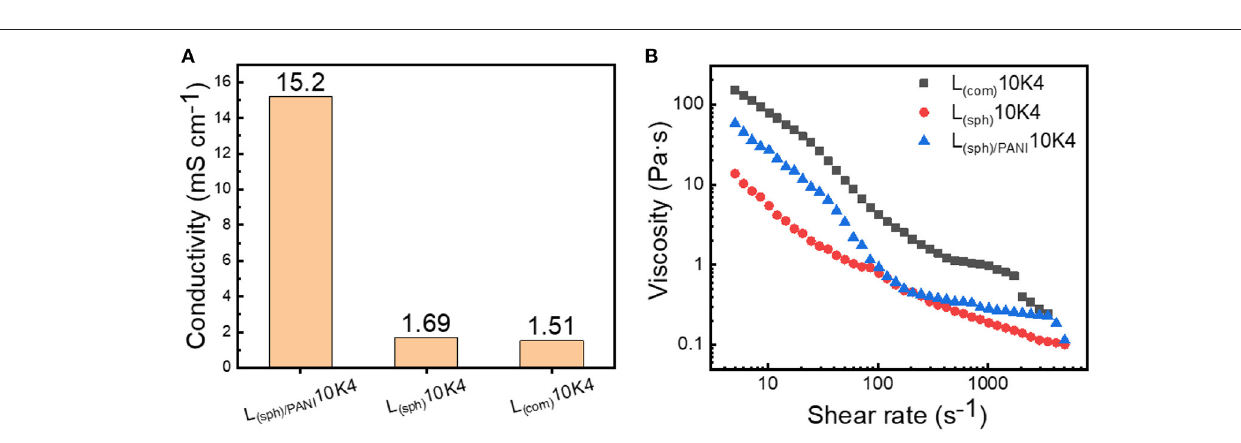
capacitance of 18.6 and 17.2 F g − 1 or volumetric capacitance